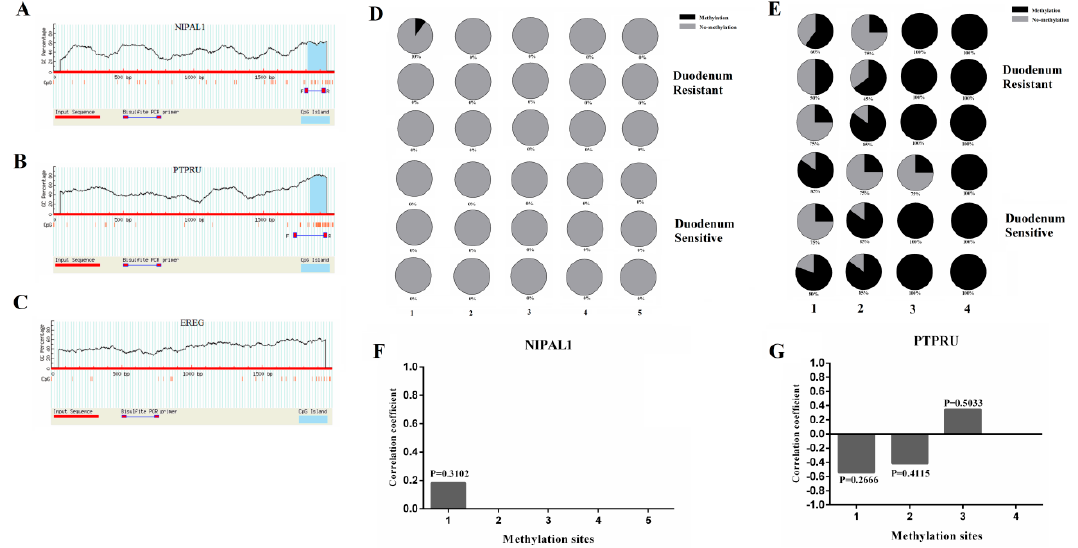
Figure 6. CpG islands prediction and methylation detection in promoter regions of miR-215 target genes. ( A – C ) CpG island prediction in promoter regions of miR-215 target genes NIPAL1 , PTPRU and the EREG gene, respectively. ( D ) and ( E ) Methylation degree in promoter regions of the NIPAL1 and PTPRU gene in F18 resistant and sensitive duodenum of Sutai piglets, respectively. ( F ) and ( G ) Correlation between methylation degree and mRNA expression of the NIPAL1 and PTPRU gene, respectively.